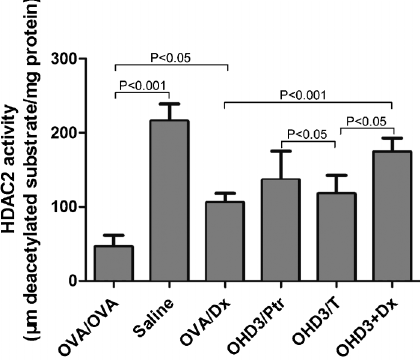
Figure 7. Effect of 1,25(OH) 2 D 3 and dexamethasone on histone deacetylase 2 (HDAC2) activity measured by a colorimetric assay kit. HeLa cell nuclear extract was used as a positive control. The activity of HDAC2 was decreased in the OVA/OVA group compared to the control group (P , 0.05); both pretreatment and treatment with 1,25(OH) 2 D 3 increased HDAC2 activity (P , 0.05). The combined treatment of 1,25(OH) 2 D 3 and dexamethasone increased HDAC2 activity compared to the OVA/OVA group and OVA/Dx groups (P , 0.001). ANOVA and Student-Newman-Keuls tests were used for statistical analyses. OHD3/Ptr: 1,25(OH) 2 D 3 pretreatment group; OHD3/T: 1,25(OH) 2 D 3 treated group; OVA/ OVA: asthma group; OVA/Dx: dexamethasone treated group; saline: the control group; OHD3++Dx: dexamethasone and 1,25(OH) 2 D 3 treated